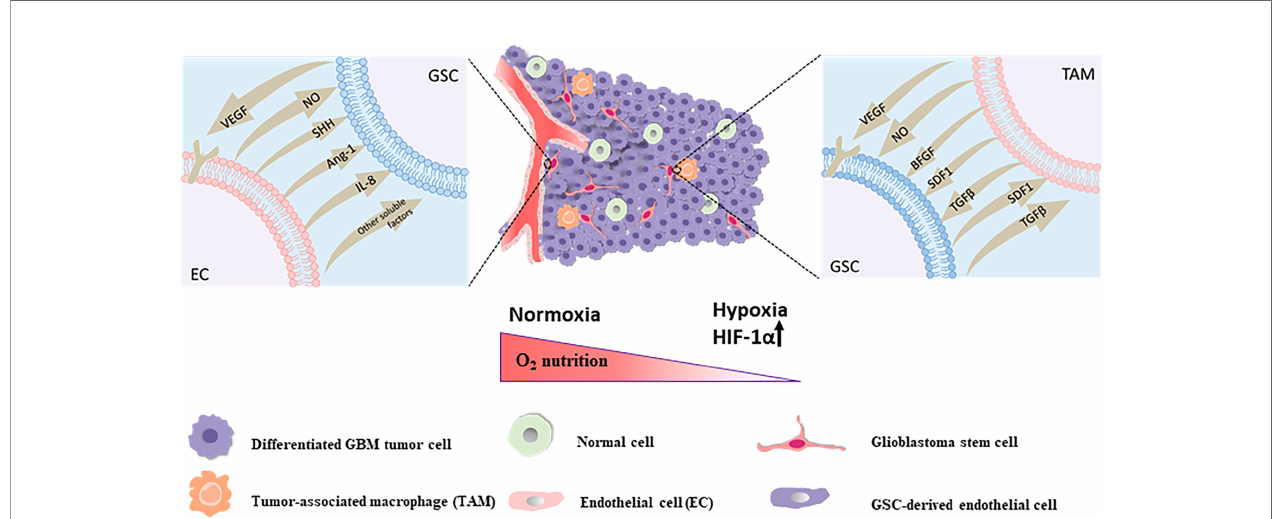
FIGURE 2 | The perivascular niche The self-renewal and maintenance of neighboring GSCs within the perivascular maintenance niche could been promoted via secretion of endothelial-derived diffusible signals including nitric oxide (NO), SHH, angiopoietin-1 (Ang-1), IL-8 and other soluble factors. GSCs are capable of stimulating the proliferation of endothelial cells and the sprouting of new vessels via secretion of VEGF and SDF-1 in the local tumor environment for sustainability and expansion of the vascular maintenance niche. The hypoxic niche With the constant invasion of GSCs, activation of hypoxia-related factors might take an active role in stemcell maintenance and one of the main factors is the hypoxia response Hypoxia Inducible Factor 1 a (HIF-1 a ). The immune niche On the one hand, for TAMs, GSCs could chemo-attract and recruit TAMs to the tumor site, prompt the growth of macrophages and induce the polarization of TAMs into the immunosuppressive M2 phenotype through secreting chemokines and growth factors like VEGF, transforming growth factor- b (TGF- b ), SDF1 and soluble colony-stimulating factor 1 (sCSF-1). On the other hand, the accumulation of these pro-tumorigenic TAMs in tumor could secrete cytokines and signaling molecules such as basic fi broblast growth factor (bFGF), TGF b , SDF1, VEGF, and nitric oxide (NO), contributing to tumor progression and GSCs maintenance in